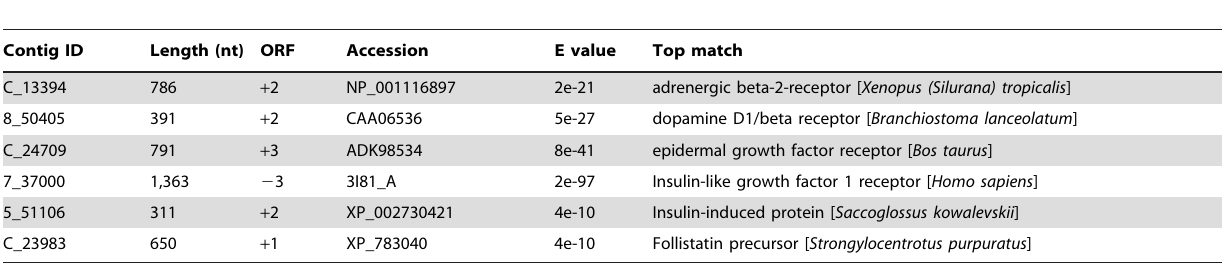
Table 3. Contigs from C. angulata with similarity to the vitellogenin amino acid sequence.